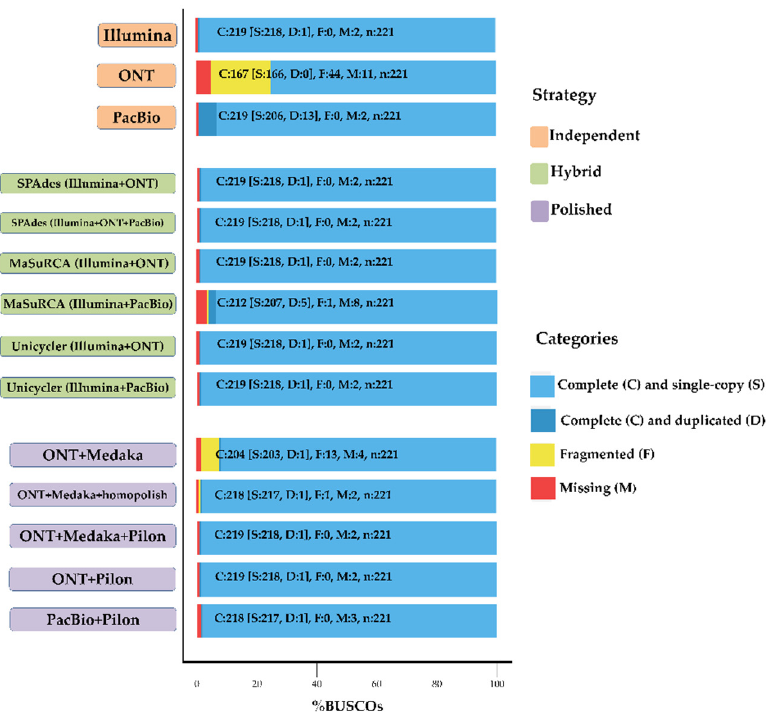
Figure 3. Evaluation of completeness of assembly results of different strategies. Assessments of the completeness of the assembly genomes with the datasets of proteobacteria_odb9 lineage. Bar charts produced with BUSCO plotting tool to show proportions that were classified as complete (C, blue), complete single copy (S, light blue), complete duplicated (D, dark blue), fragmented (F, yellow), and missing (M, red).